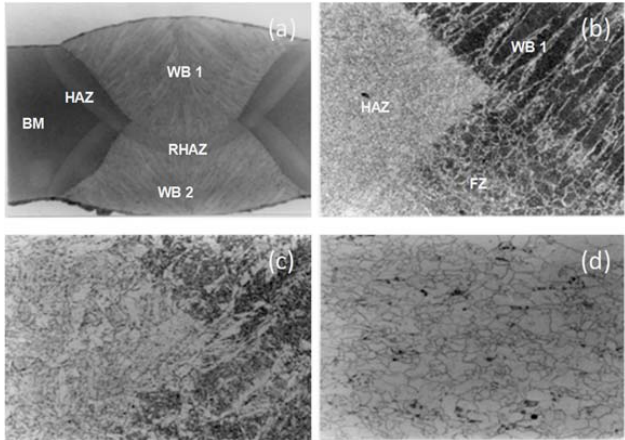
Figure 2. Microstructures of API X60 micro ‐ alloyed steel weldment: ( a ) Weldment zones; ( b ) Microstructure showing the FZ, HAZ and WB 1; ( c ) interface between HAZ and WB; and ( d ) Base Metal (BM), ferrite (light areas) and pearlite (dark areas).